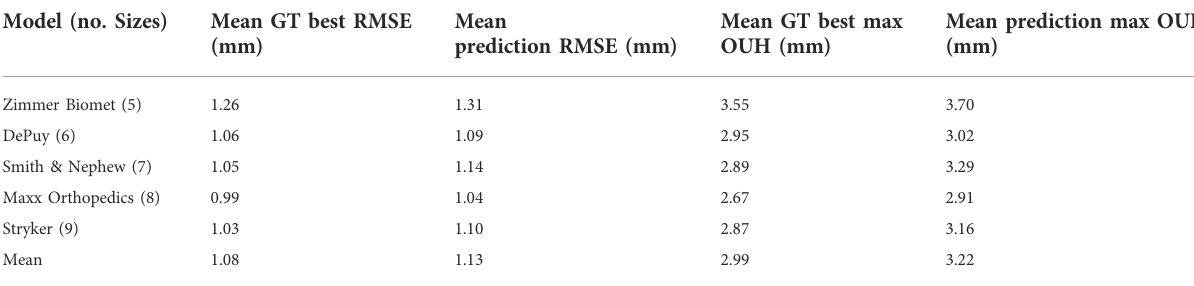
TABLE 6 Femur component mean RMSE and mean maximum OUH results for ground truth (GT) best sizes and predictions, split by manufacturer model sizings. Model (no. Sizes)